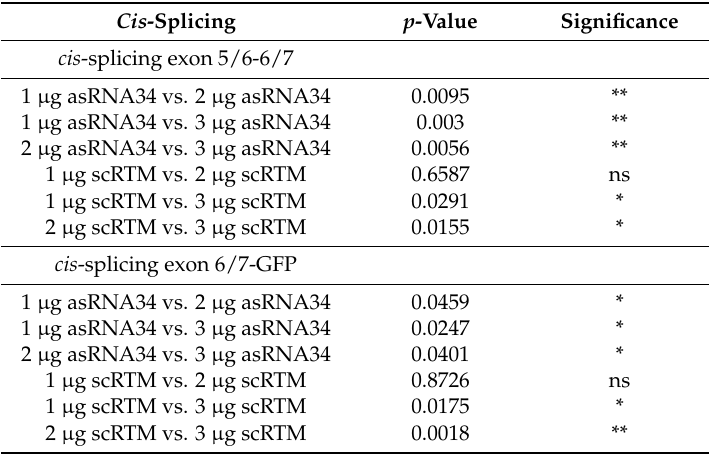
Table 3. Statistical significance cis -splicing Figure 5C,F.